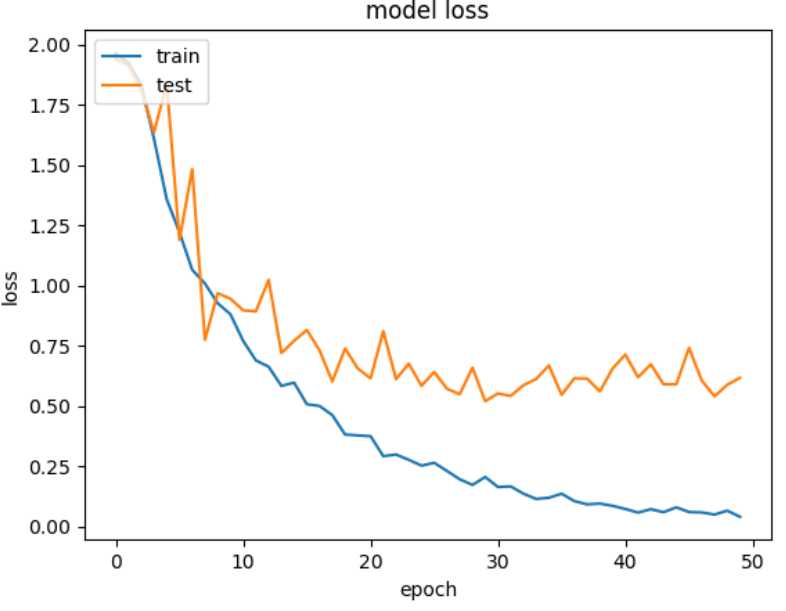
Figure 6. Model accuracy and loss of emotion